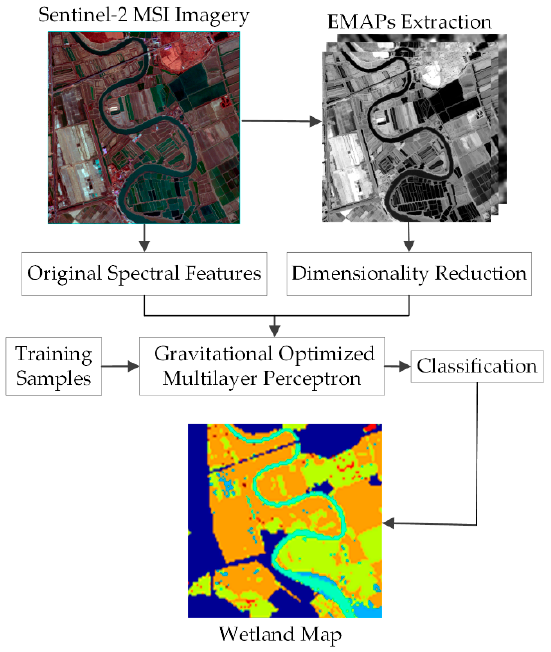
Figure1. Figure 1. Flowchart of coastal wetland mapping from Sentinel-2 multispectral instrument (MSI) imagery.